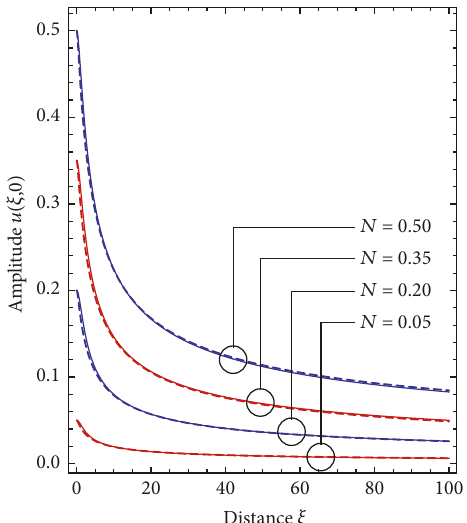
Figure 1: Amplitude evolution of weak sech pulses ( 𝑁 = 0.05 , 0.2 , 0.35 , and 0.5 , as indicated) with 𝜂 = 1 . Dashed curves: numerical data; solid curves: predictions from (10).